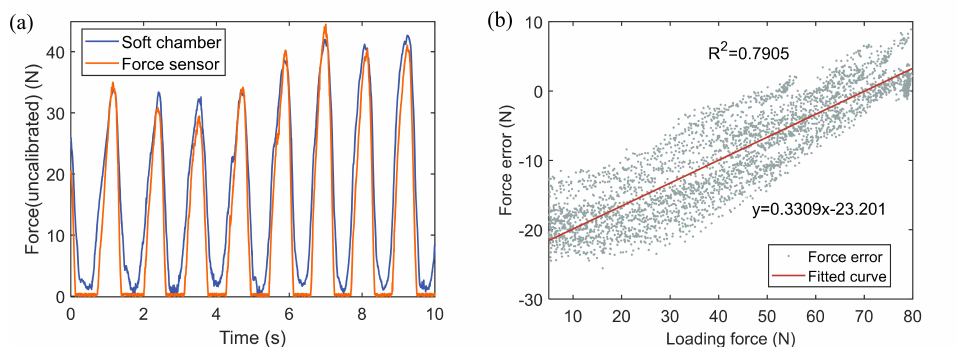
Figure 9. ( a ) Output of the developed force sensor system under dynamic loading force. ( b ) Force errors under different dynamic loading forces (5 N to 80